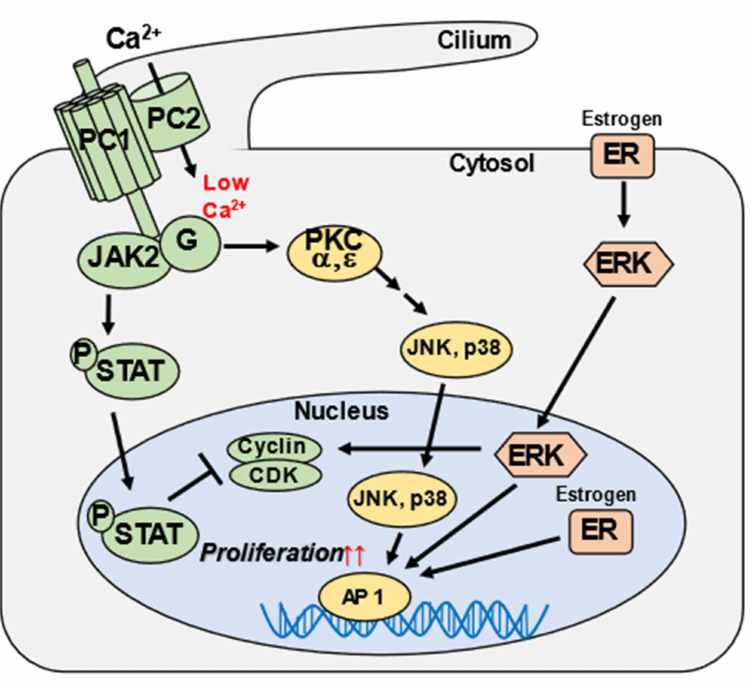
Figure 4. Signaling pathways involved in autosomal dominant polycystic kidney disease (ADPKD) pathogenesis. ADPKD is caused by mutations in PKD1 and PKD2 , which code for the polycystin proteins PC1 and PC2, respectively, which form heterodimers in the cilia of cells. PC1 and PC2 have been reported to function in various signaling pathways. PC1 and PC2 bind and form part of a protein complex found in the primary cilium that operates as a flow-regulated Ca 2+ channel. Defects in any of the complex proteins reduce Ca 2+ influx and lead to low Ca 2+ intracellular concentrations. The PC1/PC2 complex interacts with and activates JAK2, which phosphorylates STAT. STAT normally inhibits the cyclin/CDK pathways, which promote cell cycle progression; hence, its downregulation in ADPKD would increase epithelial cell proliferation. PC1 and PC2 signal via G proteins and distinct PKC isoforms to activate JNK and p38, which in turn stimulate transcription factor